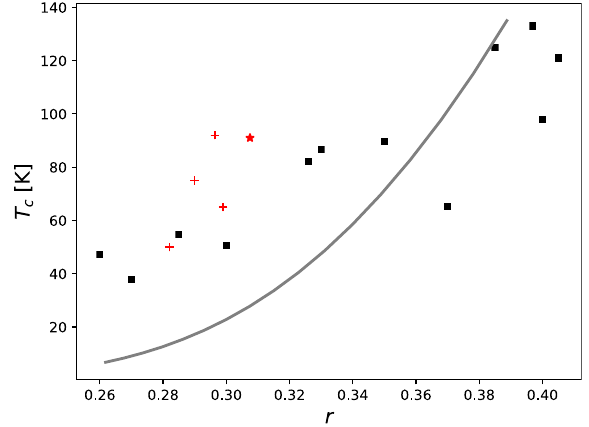
Fig. 1 Correlation between the r parameter and T c : (square) Pavarini et al. [4, Fig. 5], (plus) Vishik et al. [20] for underdoped cuprates, (asterisk) Kaminski et al. [21] and Zonno et al. [22] from ARPES data; the solid line [23] is our traditional BCS interpretation for s-d exchange amplitude J sd approximately equal for all cuprates, which is a fitting parameter of the theory and can be used to deter‑ mine the intensity of the scattering rate in the normal phase. The value of J sd used to obtain the curve in the figure is 7.23